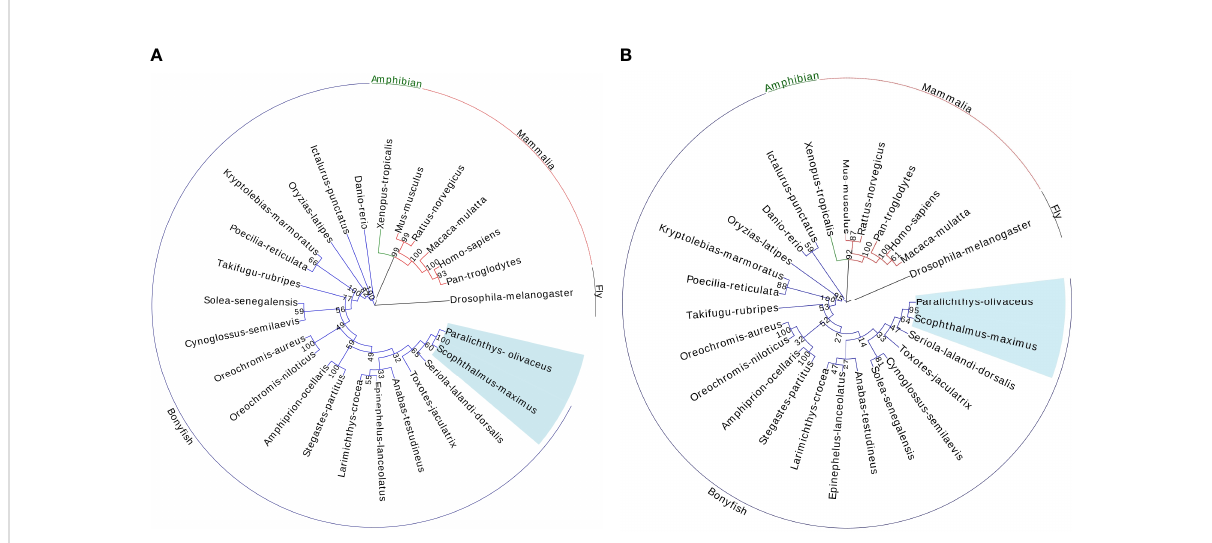
FIGURE 2 Phylogenetic tree of the selected Drosha sequences by the Neighbor-Joining method (1000 bootstrap) (A) and by the maximum-likelihood method (1000 bootstrap) (B) . Bootstrap values are shown at the branch points. Scale bar indicates the number of changes inferred as having occurred along each branch. The Drosha amino acid sequences used for analysis are extracted from the GenBank database.